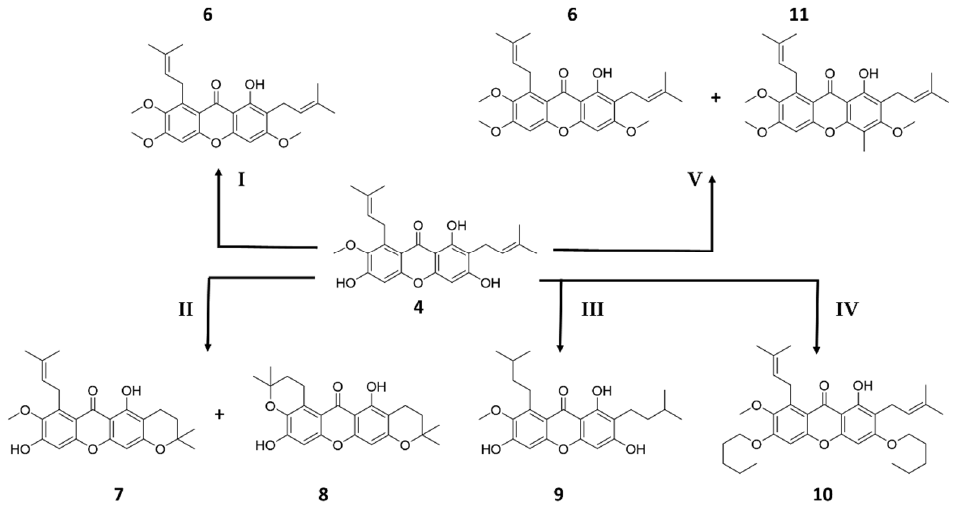
Figure 1. Isolated compounds ( 1 – 5 ) from the pericarp of G. mangostana (Clusiaceae).